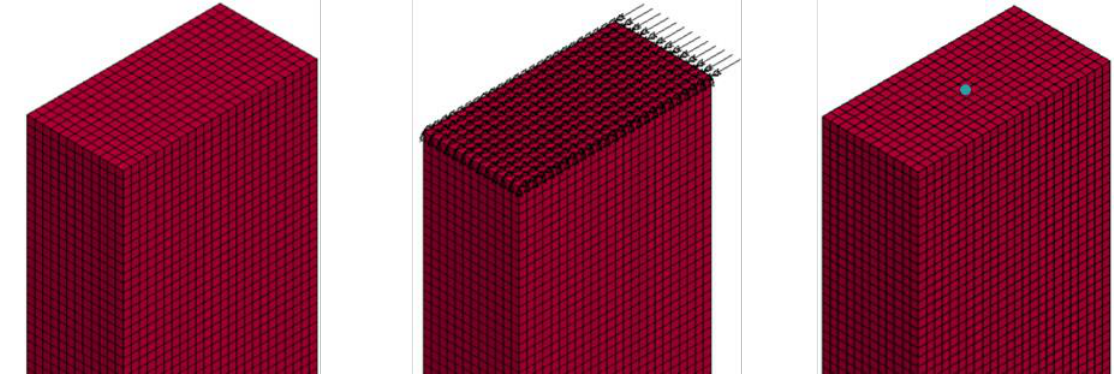
Figure 25. Simplified description of superstructure in case 2, 3 and 4 (from left to right).